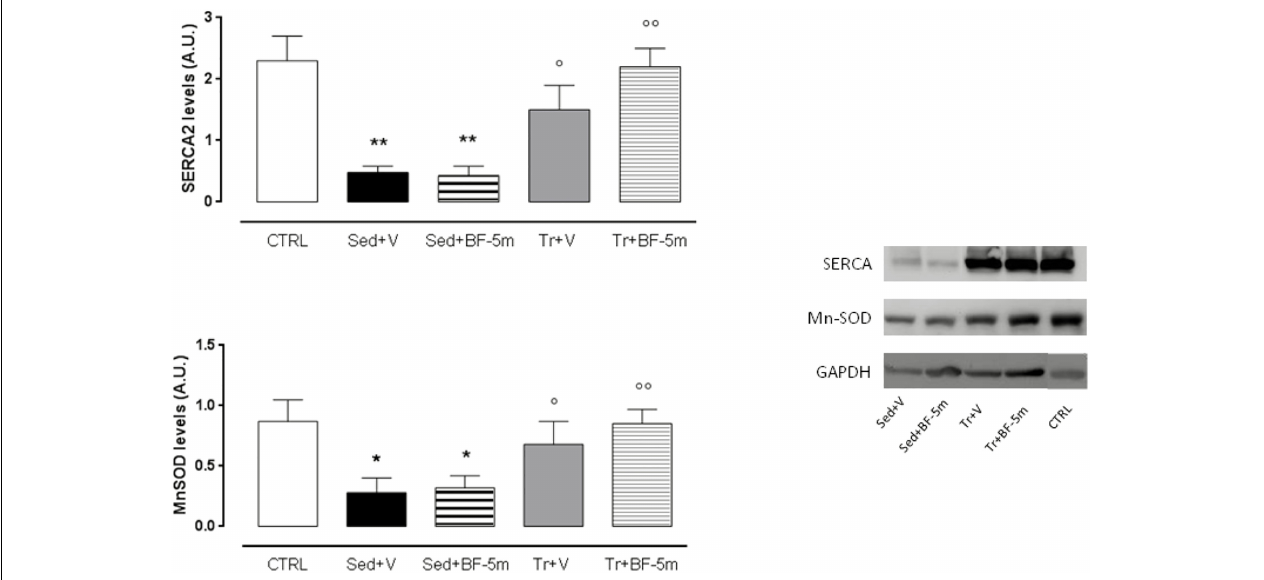
FIGURE 4 | Western blot of SERCA2 and MnSOD. Experimental treatment were performed as described in Figure 1 . Results are reported as mean of five observations ± S.E.M. CTRL, healthy control rats; Sed+V, diabetic sedentary rats treated with vehicle; Sed+BF-5m, diabetic sedentary rats treated with BF-5m 20 mg/kg/day; Tr+V, diabetic trained rats treated with vehicle; Tr+BF-5m, diabetic trained rats treated with BF-5m 20 mg/kg/day; A.U., arbitrary units; ∗ P < 0.05 and ∗∗ P < 0.01 vs. CTRL; ◦ P < 0.05 and ◦◦ P < 0.01 vs. the same pharmacological treatment in the sedentary